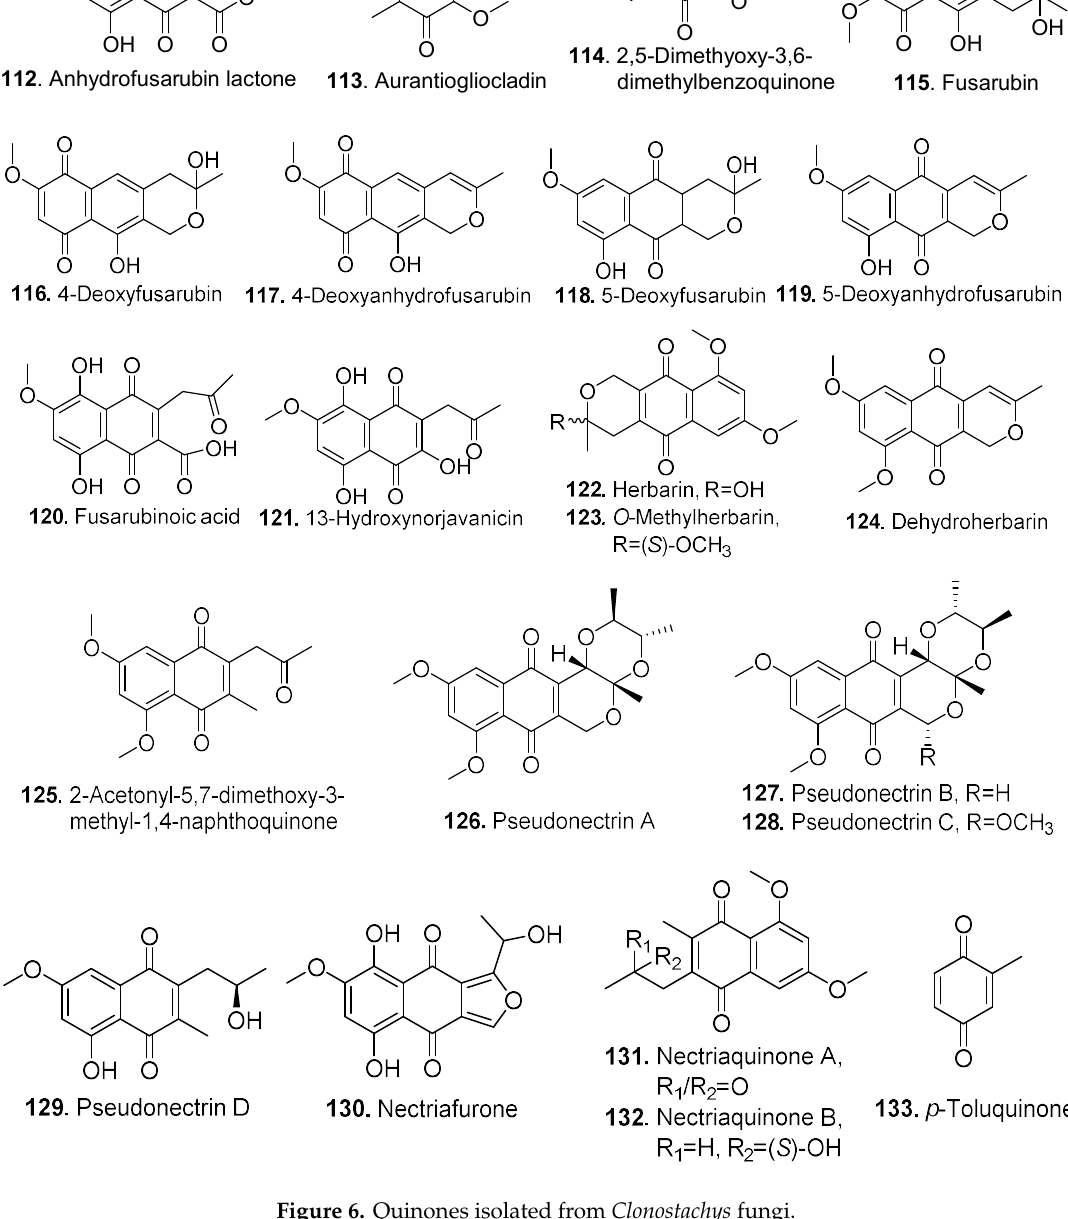
Figure 6. Quinones isolated from Clonostachys fungi.